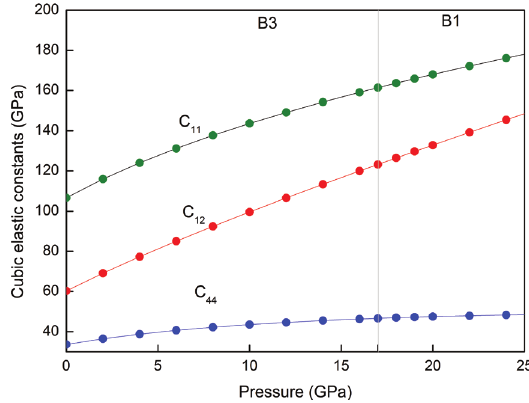
Figure 2. Pressure dependence of density in GaAs up to 25 GPa.